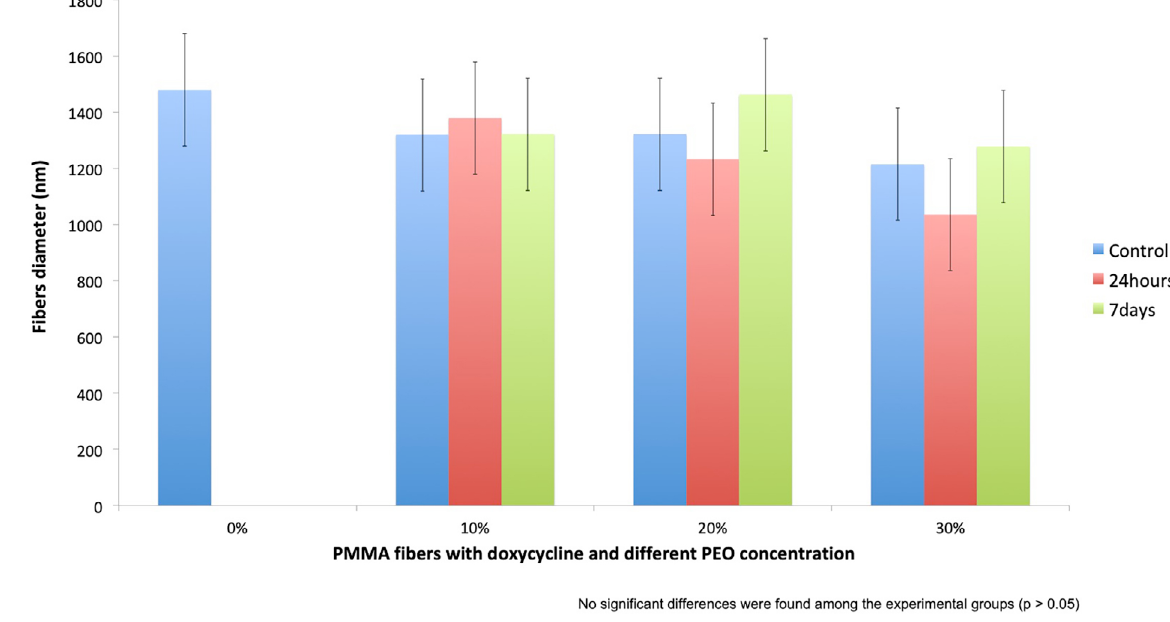
Figure 5- Fiber diameter (nm) with different PEO concentrations at post-spinning, 24 hours, and 7 days water